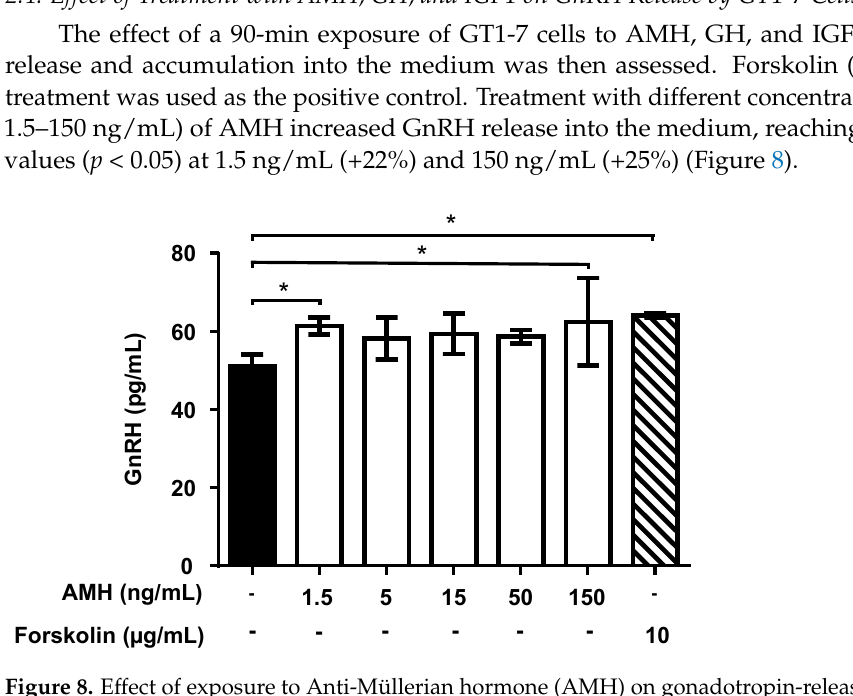
Figure 9. Effect of exposure to growth hormone (GH) on gonadotropin-releasing hormone (GnRH) release by GT1-7 cells. Cells were incubated for 90 min with different concentrations of GH. Data are expressed as mean ± SD, n = 4. One experiment representative of three separate experiments is shown. *** p < 0.001; **** p < 0.0001 vs. Control (black bar) (One-way ANOVA followed by the Dunnett post-hoc test). GnRH release by GT1-7 cells was also moderately, but significantly ( p < 0.05 or <0.01), stimulated by 3 and 10 ng/mL IGF1, but not at lower (0.3 and 1 ng/mL) and higher (30 and 100 ng/mL) concentrations (Figure 10).